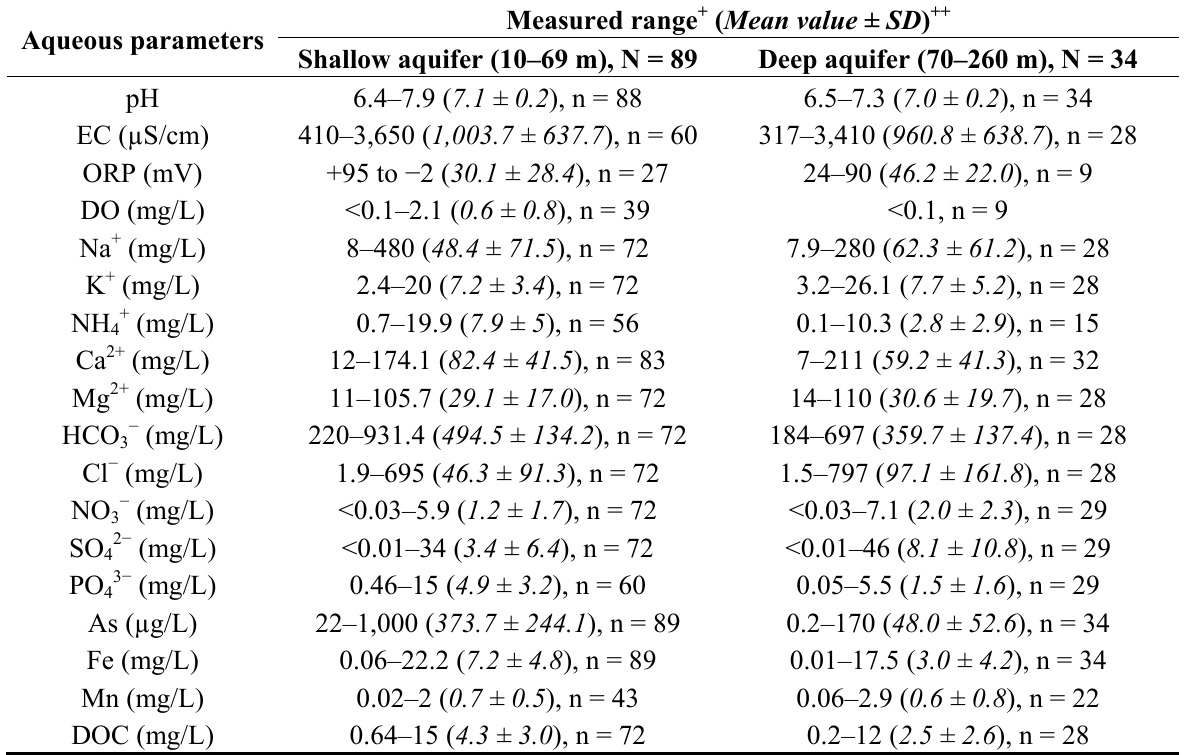
Table 2. Average groundwater composition of the most As contaminated areas * in the Bengal Delta Plain (BDP) in